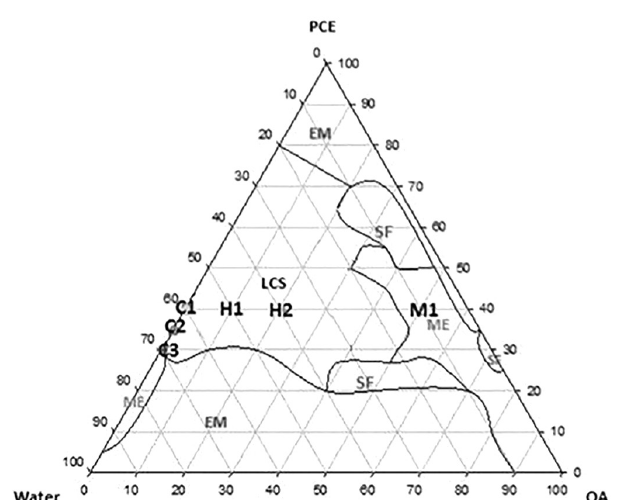
FIGURE 2 - Phase diagram of W, OA, and PCE indicating areas where the formulation will exist as fully phase-separated (SF), as a microemulsion (ME), as a cloudy system (EM), or as a liquid crystalline system